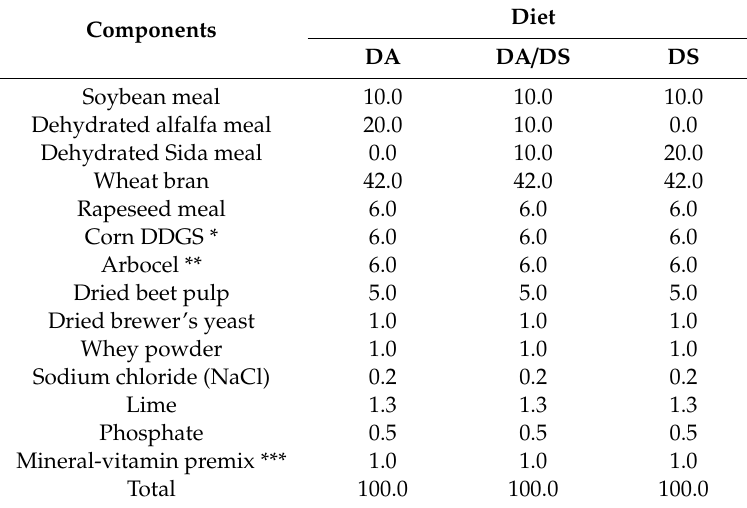
Table 1. Composition of diets (%).